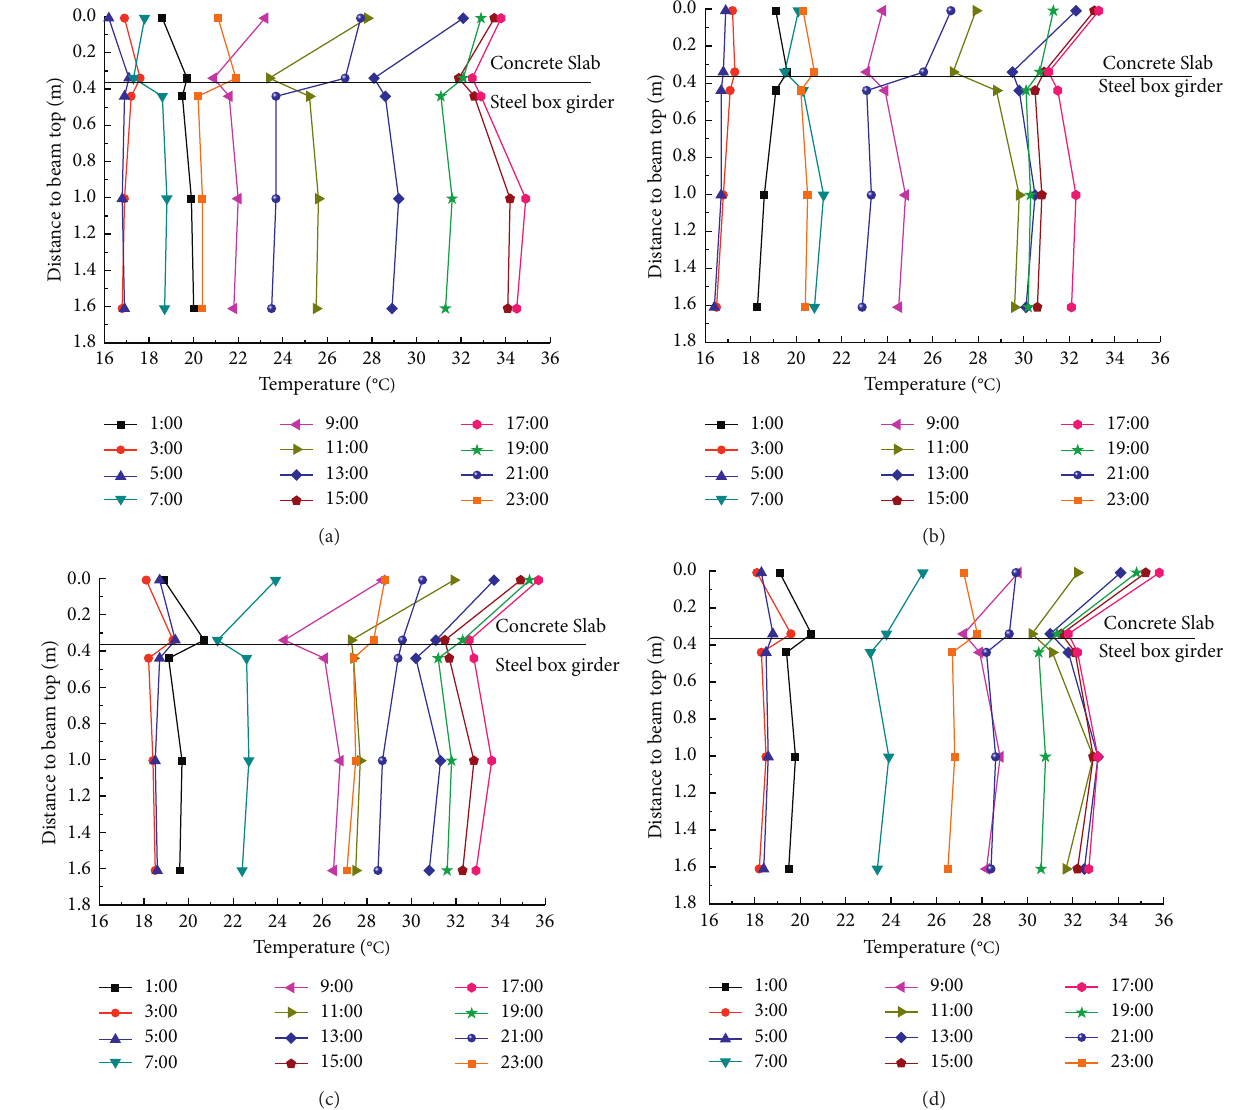
Figure 9: Curves of the temperature gradient on the vertical section. (a) West section on June 7. (b) East section on June 7. (c) West section on June 11. (d) East section on June